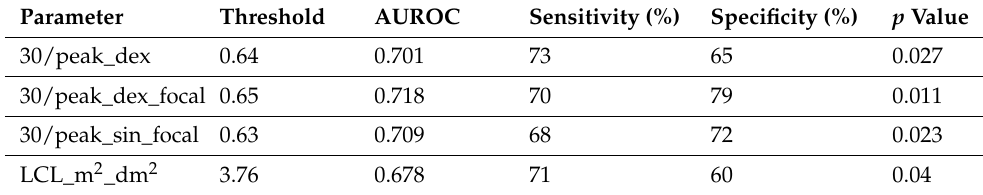
Table 3. Dynamic scintigraphic quantitative parameters discriminating mild fibrosis (F1 vs. F2–F4).